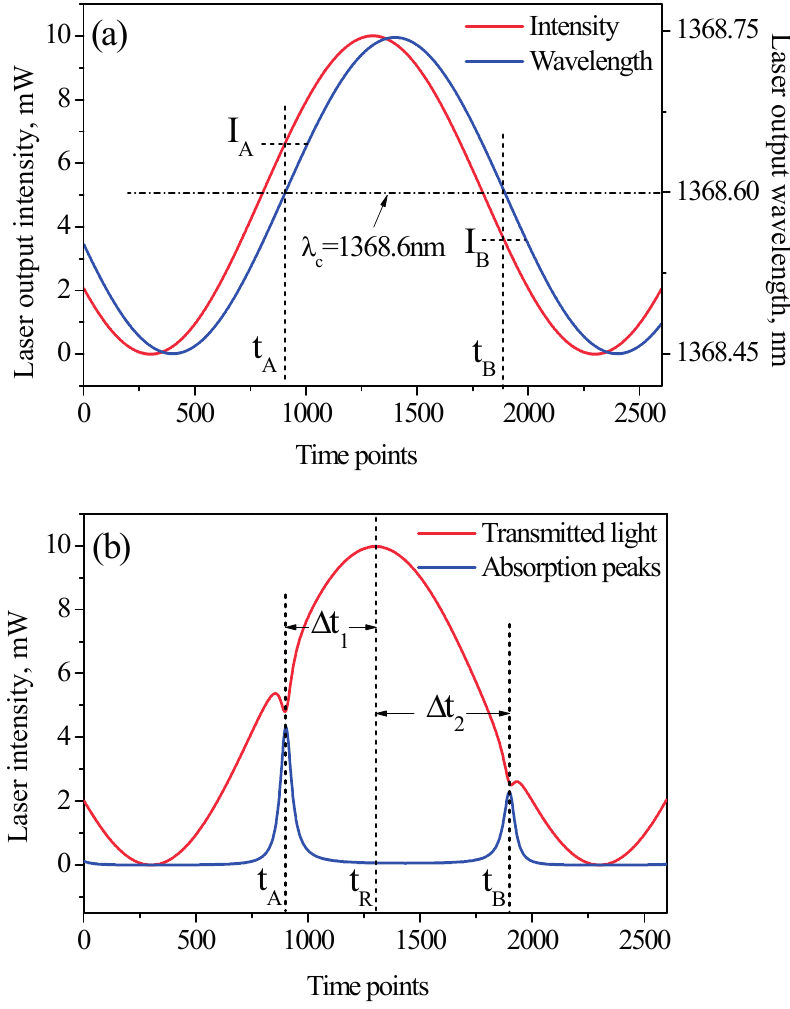
Figure 2. ( a ) DFB-LD output intensity (red) and wavelength (blue) with a phase shift of 0.1 π ; ( b ) Transmitted light intensity (red) and absorption peaks